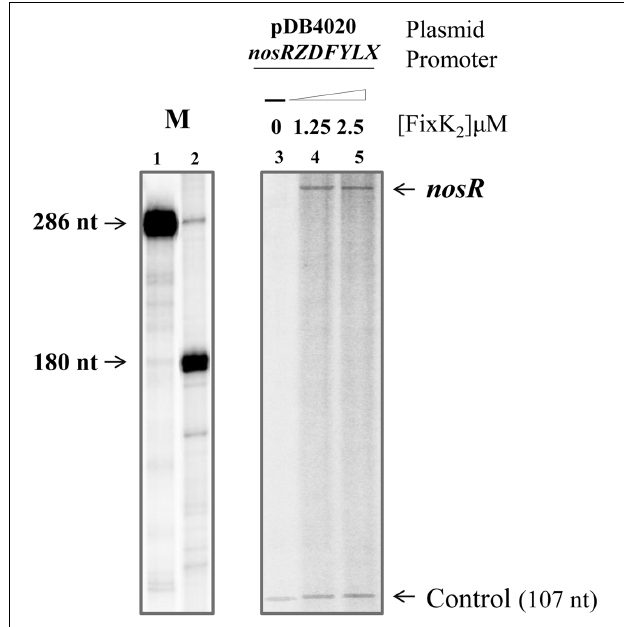
FIGURE 5 | FixK 2 -mediated IVT activation from the nosRZDFYLX promoter. pDB4020 plasmid containing the nosR promoter cloned upstream of the rrrn terminator was used for multiple-round IVT assays with different amounts of purified FixK 2 protein and RNAP from B. diazoefficiens . FixK 2 concentrations were as follows: no protein, 1.25 and 2.5 µ M (lanes 3–5). Transcripts synthesized in vitro in the presence of [ α − 32 P]UTP were separated on a 6% denaturing polyacrylamide gel and visualized by phosphorimager analysis of the dried gel. Markers transcripts (M) of 286 and 180 nucleotides loaded in lanes 1 and 2 were produced as described by Mesa et al. (2005). The 107-nucleotide transcript present in all lanes originates from a promoter located on the plasmid vector and serves as internal reference. Shown are the results from a transcription experiment that was repeated at least once. Both panels correspond to the same gel. nt,